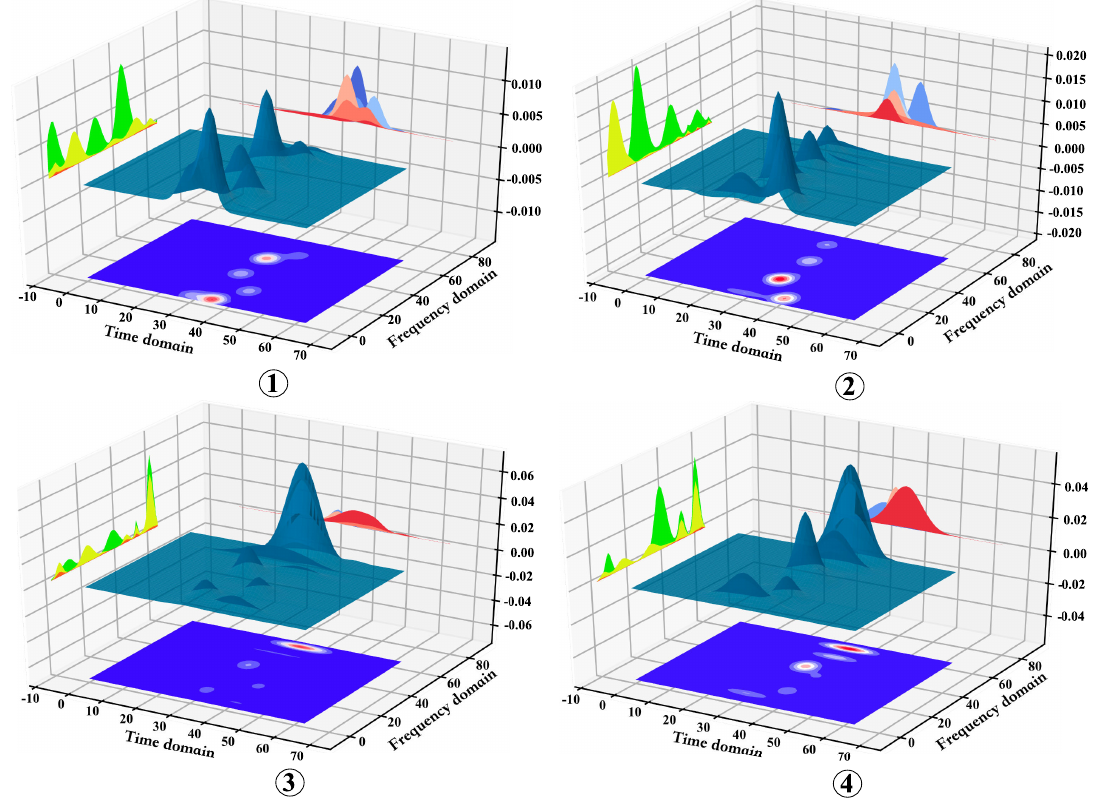
Figure 9. Multi-domain HRPP